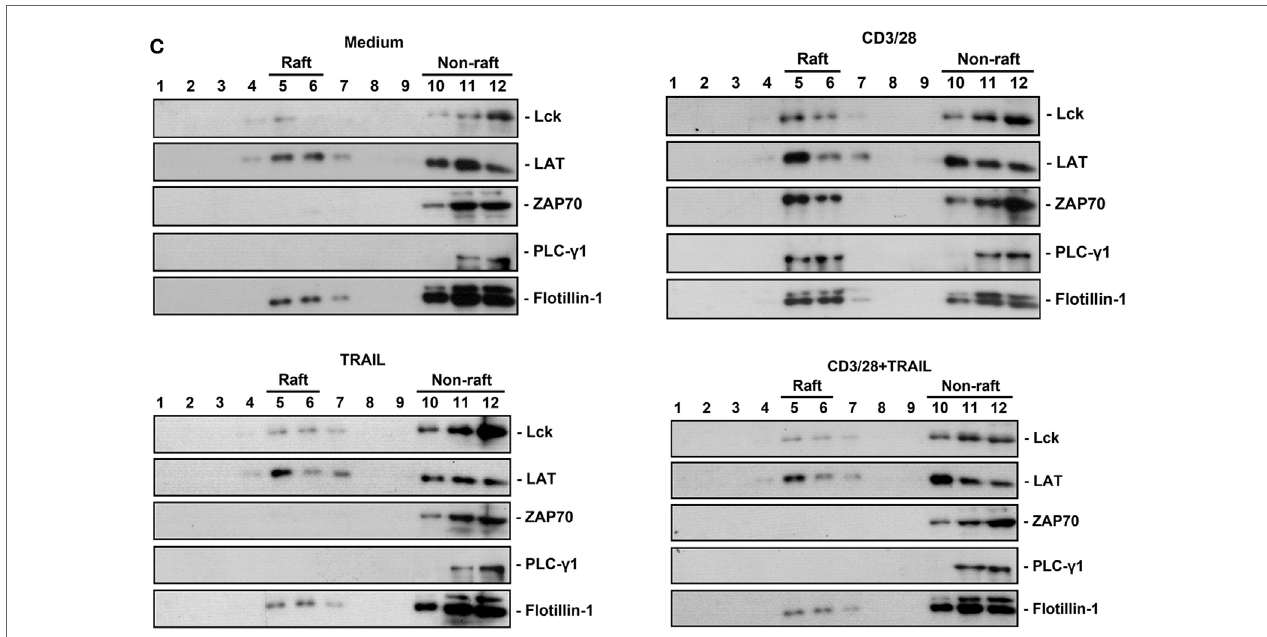
FigUre 6 | TRAIL inhibited T cell activation by suppressing phosphorylation of proximal T cell receptor signaling molecules. (a) 2 × 10 6 primary splenic CD4 + T cells from C57BL/6 wild-type (WT) and TRAIL-R KO mice were stimulated at the indicated time point with medium, an anti-CD3 antibody (Ab; 1 µg/ml), an anti-CD28 Ab (1 µg/ml), and TRAIL (10 µg/ml), or a combination of anti-CD3/anti-CD28 Abs and TRAIL. Lysates of each group were prepared and immunoblotted with antiphospho-ZAP70 (Tyr319), anti-ZAP70, antiphospho-LAT (Tyr191), anti-LAT, antiphospho-PLC γ 1 (Tyr783), anti-PLC γ 1, and antiactin Abs. Blots are representative of three independent experiments performed. (B) 2 × 10 6 primary splenic CD4 + T cells from C57BL/6 mice were stimulated for 2 h at 37°C with medium, anti-CD3/ anti-CD28 Abs, TRAIL, or combination of anti-CD3/anti-CD28 Abs and TRAIL. Cells were fixed, permeabilized, and stained with anti-p-ZAP70 Ab or anti-p-PLC γ 1 Ab. Representative figures for each group are shown (left panel) and quantified (right panel) from four independent experiments in each group. ** p < 0.01 by non-parametric Mann–Whitney U -test. (c) 2 × 10 7 primary splenic CD4 + T cells from C57BL/6 mice were stimulated for 24 h with medium, anti-CD3/anti-CD28 Abs, and TRAIL, or a combination of anti-CD3/anti-CD28 Abs and TRAIL. Cell were lysed and subjected to sucrose density gradient centrifugation to isolate lipid rafts. Proteins from equal volumes of representative collected fractions were immunoblotted with anti-Lck, anti-LAT, anti-ZAP70, anti-PLC γ 1, and anti-flotillin-1 Abs. Blots are representative of three independent experiments